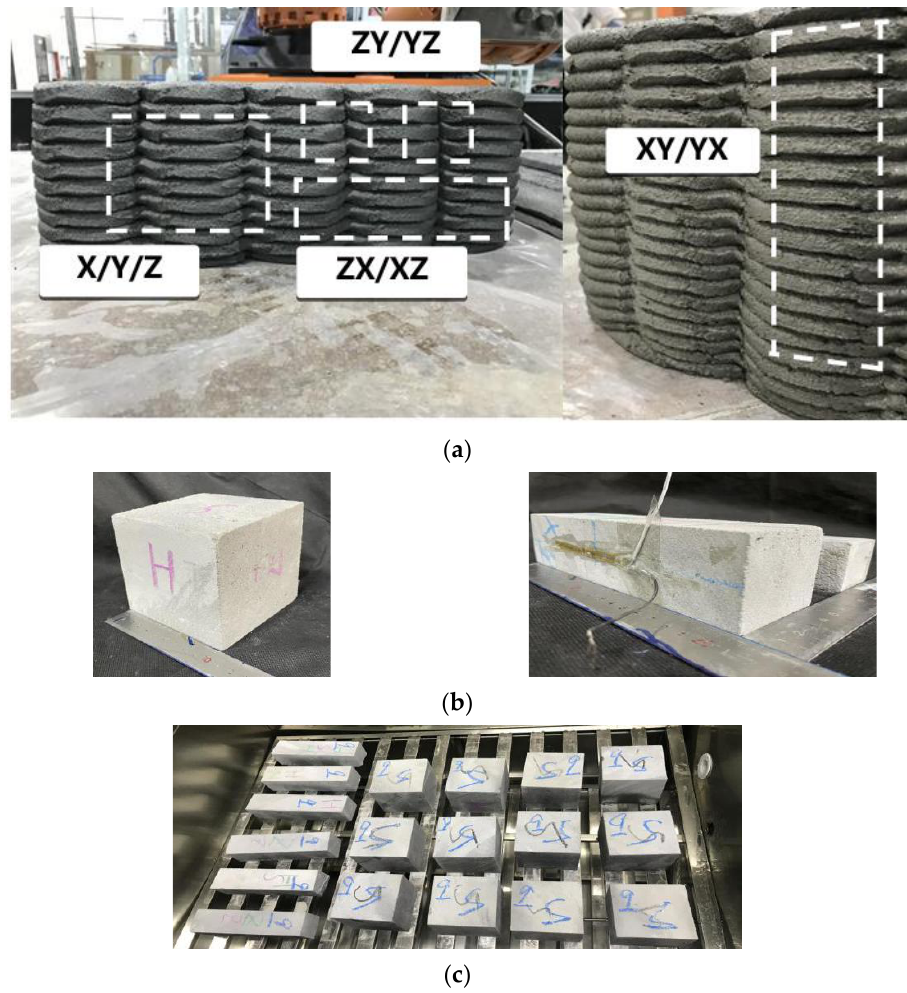
Figure 4. ( a ) Cutting position, ( b ) specimen size, and ( c ) steam curing condition [60].